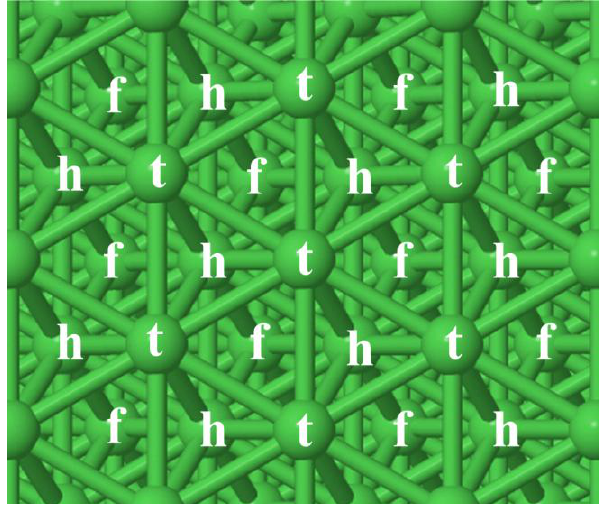
Figure 1. Top (t), hollow hcp (h) and hollow fcc (f) sites on the Ni(111).